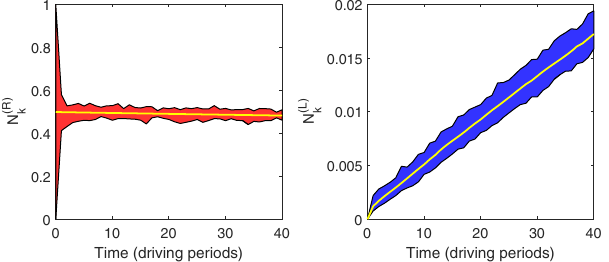
FIG. 8. Particle distribution in single-particle Floquet states in the right- and left-moving Floquet bands, N ð R Þ function of time. In both figures, we indicate only the maximal and minimal occupations, max the area between them. In both plots, the yellow line indicates the average occupation ð 1 =L Þ be seen from the left figure, the distribution in the right-moving